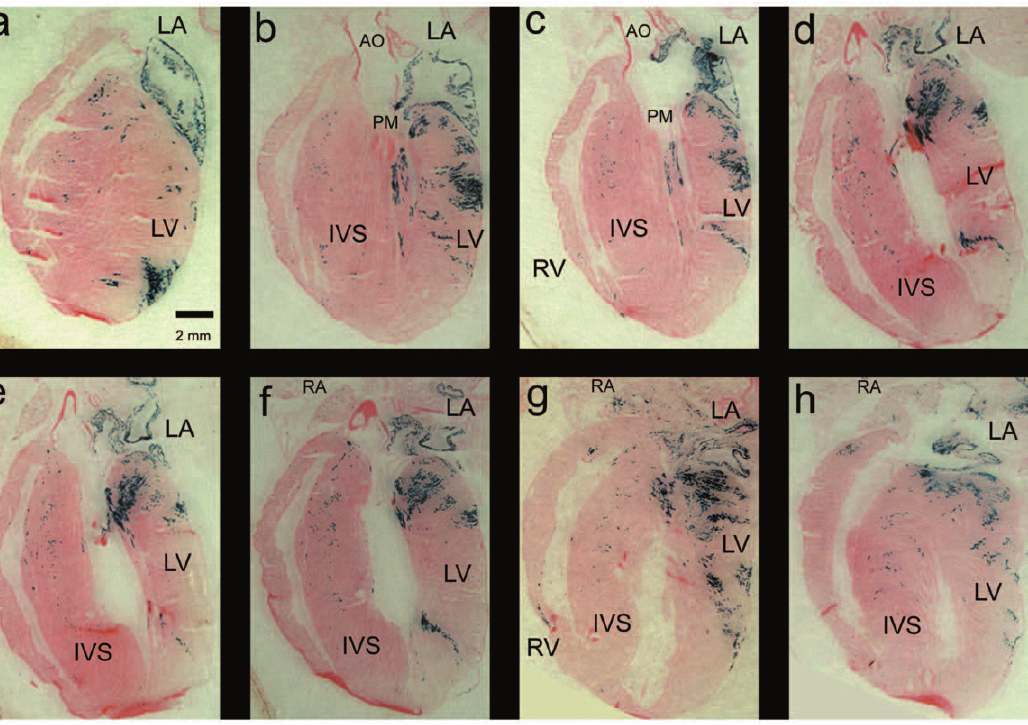
Figure 1. Pnmt-Cre activation of b -gal expression in adult mouse heart sections. Representative series of frontal sections (ventral-dorsal orientation) from an adult mouse heart resulting from Pnmt Cre/Cre , ROSA + / + 6 Pnmt + / + , ROSA26 b gal/ b gal matings to produce offspring that are Pnmt + /Cre , ROSA26 + / b gal . When the offspring reached adulthood (8–10 weeks), they were sacrificed, and the hearts were fixed and processed for XGAL staining (blue). Similar patterns were seen with hearts isolated at 3–6 months of age (not shown). The tissue was counterstained with eosin (pink) for contrast. Abbreviations: RA, right atrium; LA, left atrium; RV, right ventricle; LV, left ventricle; AO, aorta; PM, papillary muscle; IVS, interventricular septum.